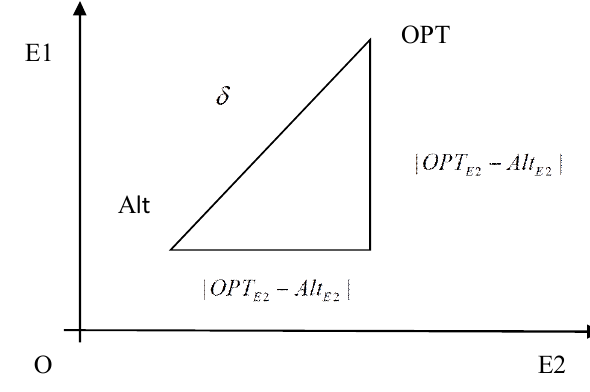
Fig 3. Distances of Real Vector in 2 – Dimensional